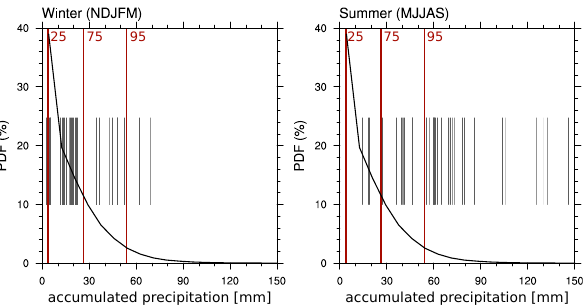
Figure 4. Probability density function of the accumulated precip- itation from ERA-Interim of Vb events (black line) for extended winter (left panel) and extended summer (right panel). The red lines indicate the 25, 75 and 95 percentile from left to right. The vertical, black lines indicate the accumulated precipitation of all Vb cyclones occurring during each season,